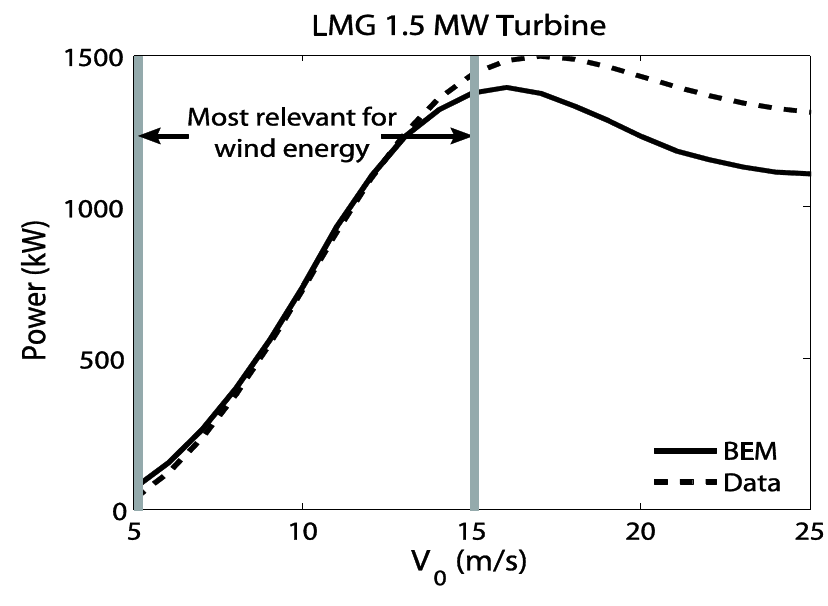
Figure 3. LMG power comparison as a function of wind